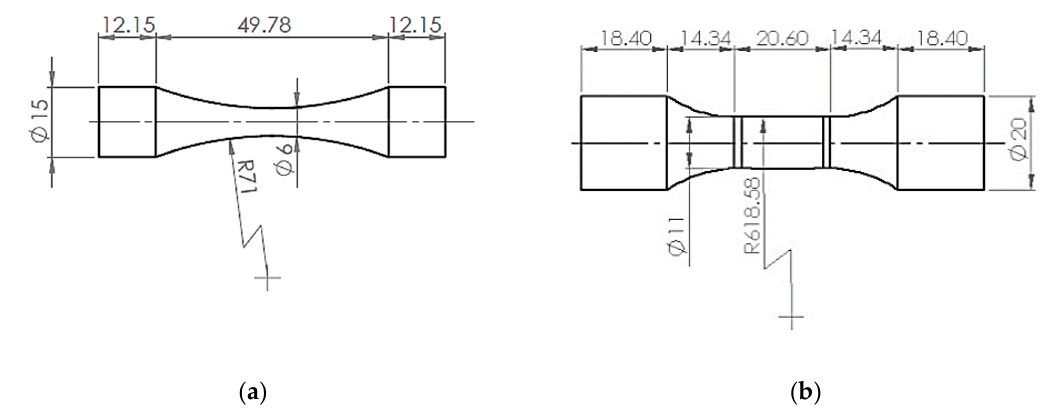
Figure 1. Drawings of tested specimens: ( a ) hourglass specimen; ( b ) Gaussian specimen.